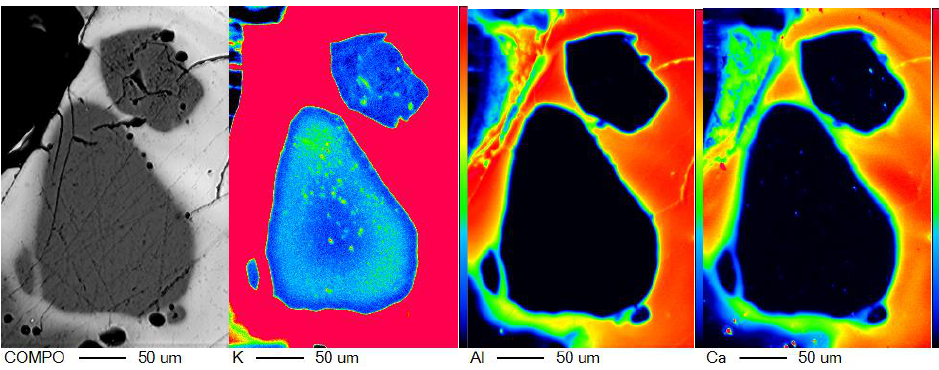
Figure 10. Chemical mapping of two adjacent relic quartz grains. Distribution of Na generally follows K and is decoupled from Al. See text for detail.